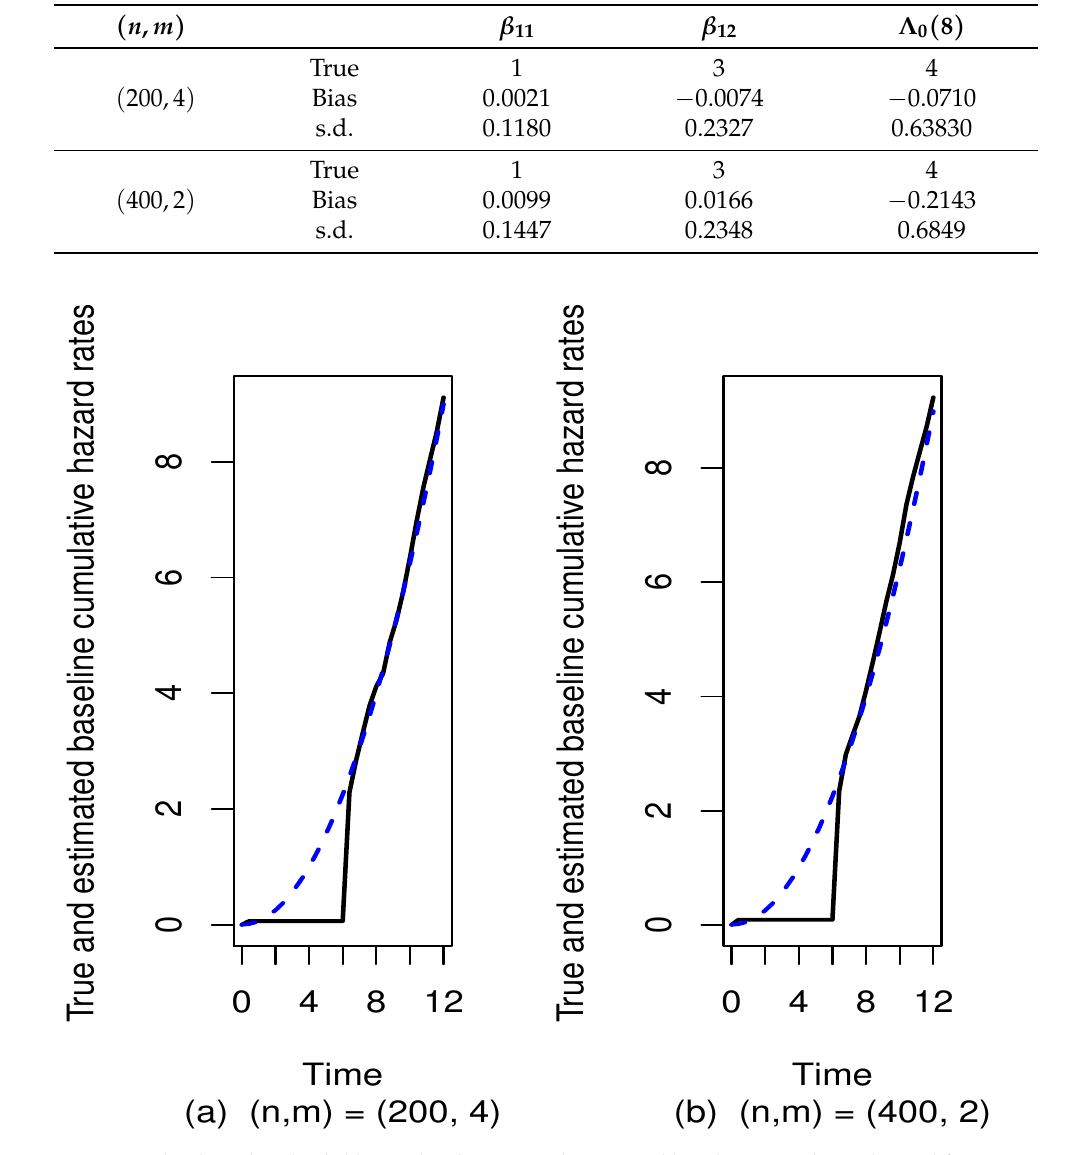
Figure 1. The dotted and solid lines plot the true and estimated baseline cumulative hazard functions, respectively. The estimated baseline cumulative hazard function is the empirical average of the estimated baseline cumulative hazard functions based on 50 replications with ( n , m ) = ( 200,4 ) or ( 400,2 ) in Example